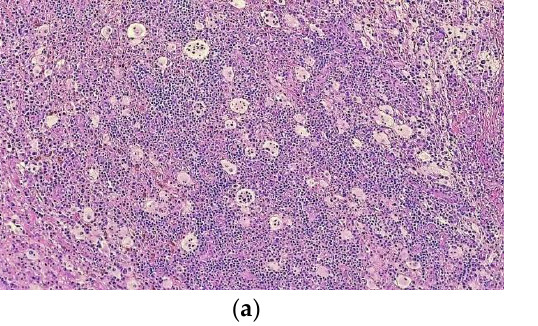
Figure 7. Prominent population of histiocytes characterized by large, round nuclei and voluminous cytoplasm showing emperipolesis with engulfment of lymphocytes ( a ) HE staining; 40×; ( b ) HE staining 400×.